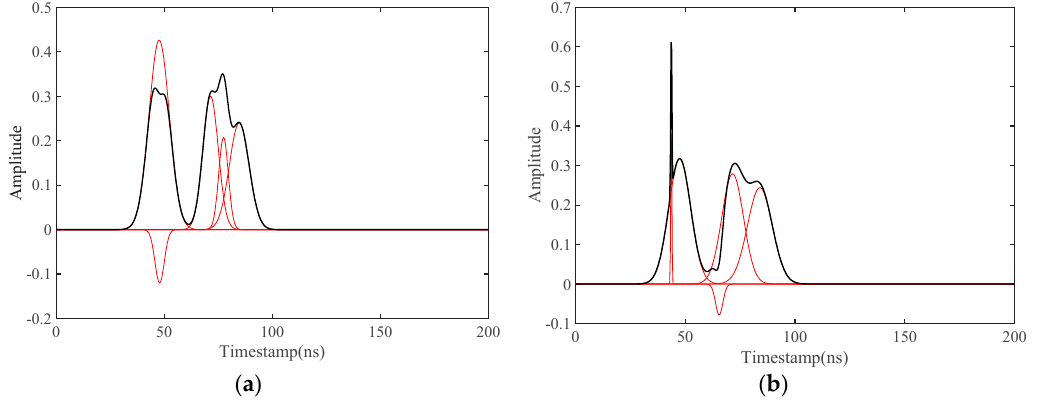
Figure 6. ( a , b ) Negative amplitudes resulting from Gaussian decomposition. Red curves represent individual scatterers, while the sum of all Gaussian functions are shown in black.